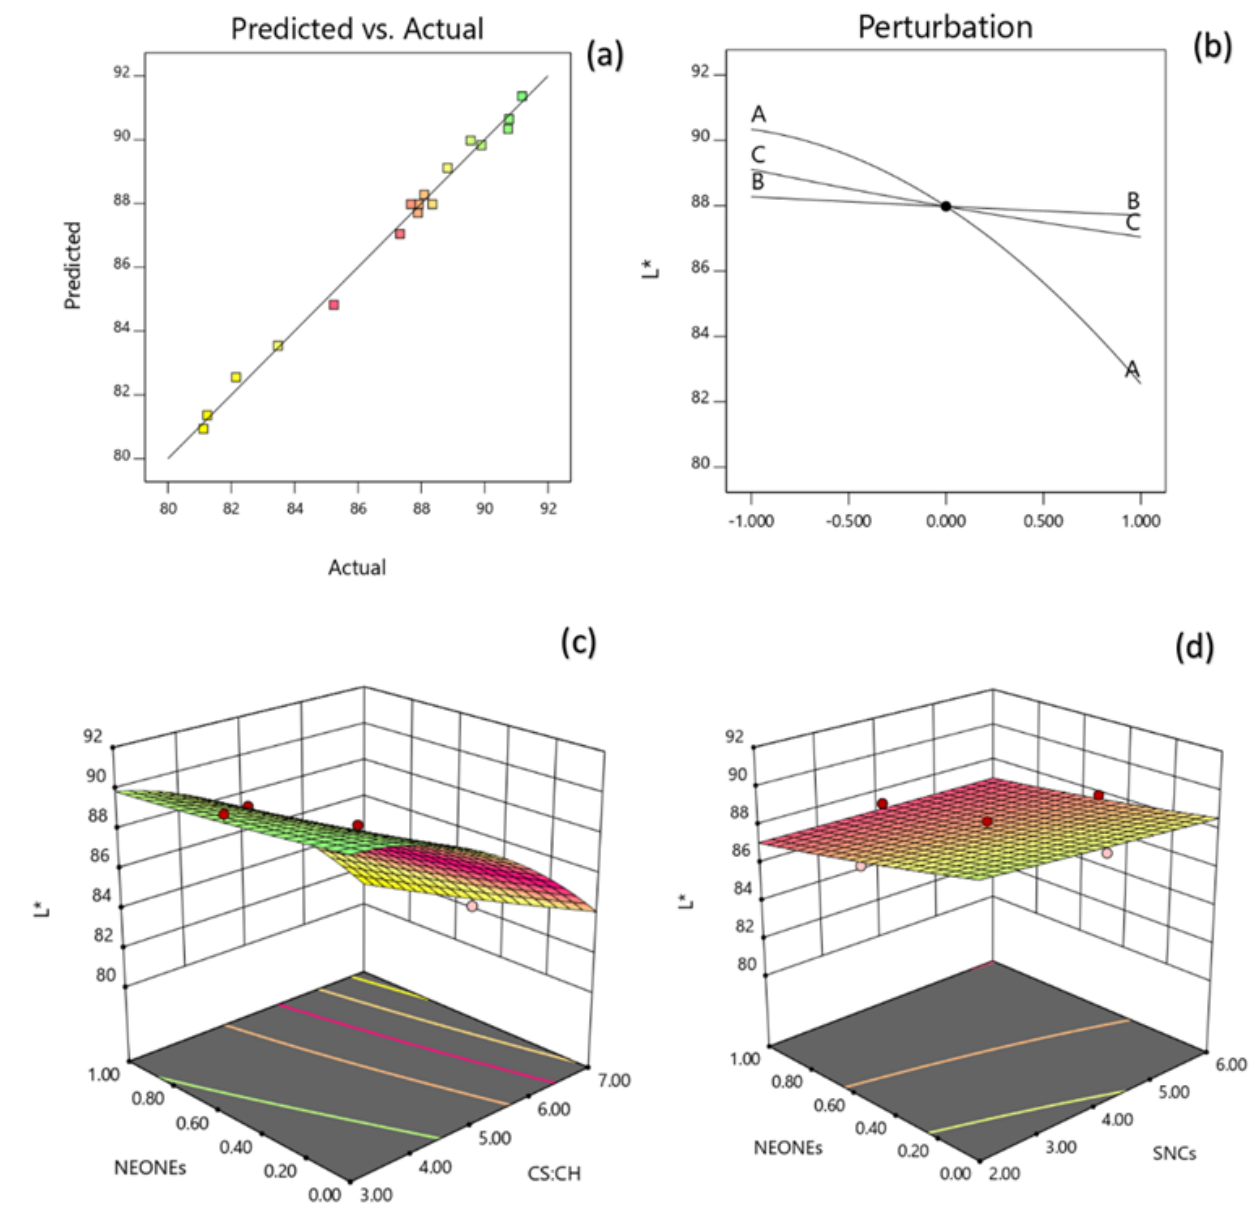
Figure 5. Counter and perturbation graphs ( a , b ), the interaction between CS:CH and SNCs concentration and also interaction between SNCs and NEONEs concentration on L* parameter of the produced film ( c , d